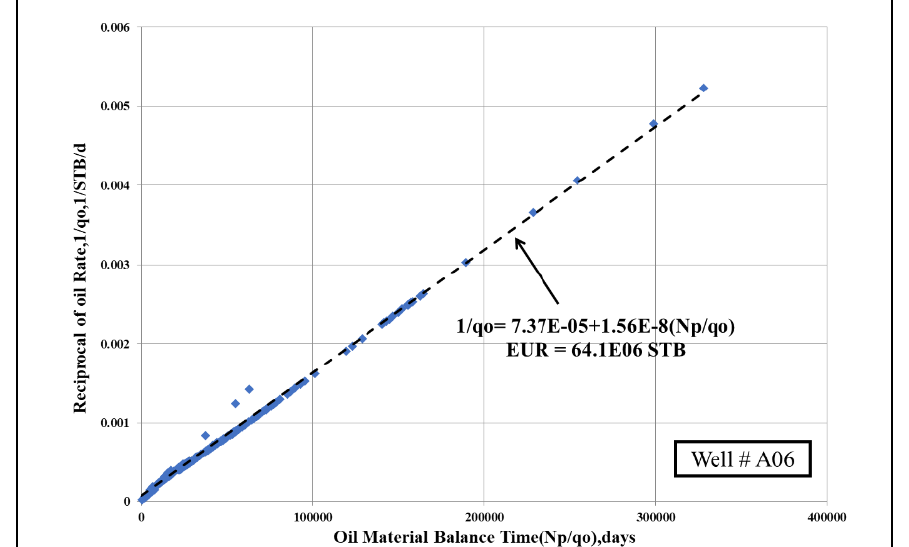
Figure 9. Reciprocal of oil rate, 𝟏/𝒒 𝒐 versus oil material balance time, to for well A06